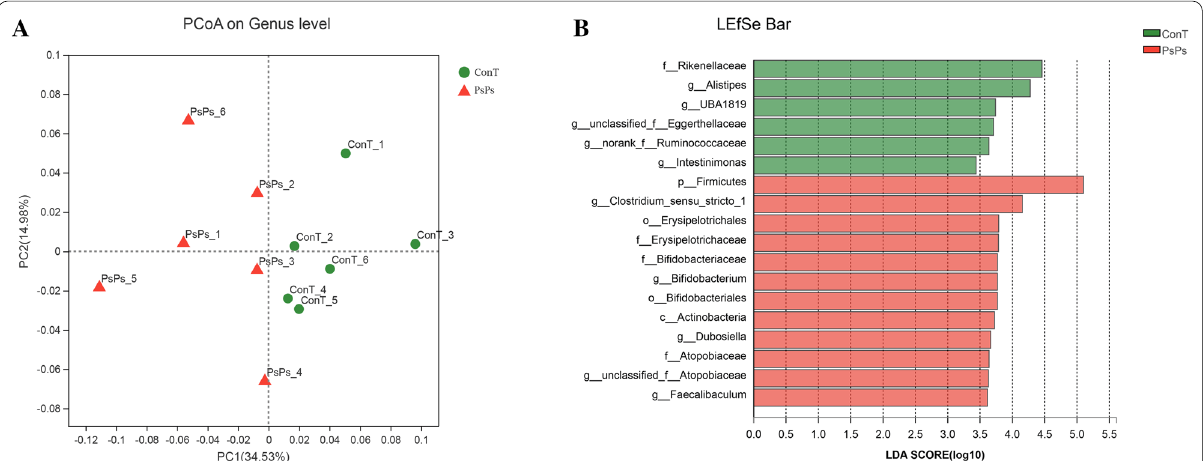
Fig. 3 A PCoA analysis was performed based on weighted UniFrac distances. B The LDA scores of the PsPs group and the ConT group were obtained by LEfSe analysis